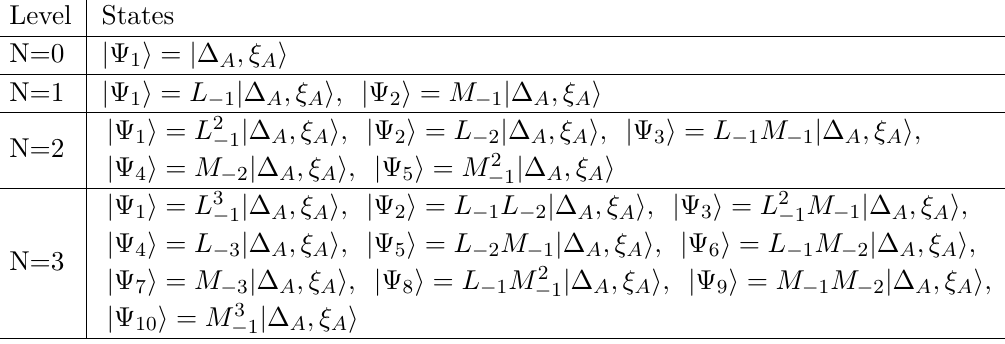
Table 1 . States in the BMS module upto level